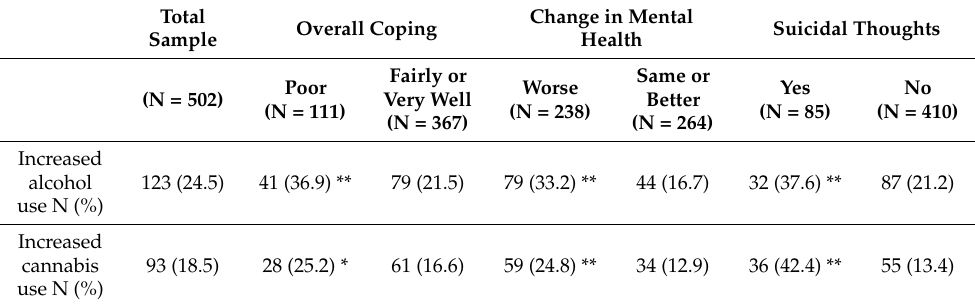
Table 2. Increased alcohol and cannabis use by mental health outcomes among LGBTQ2+ respondents to a national Canadian repeated survey during the COVID-19 pandemic, 2020–2021.